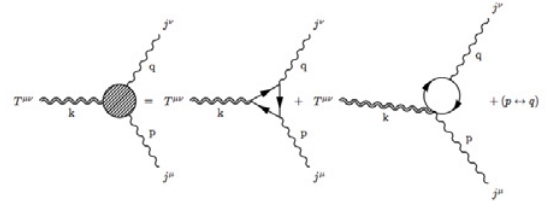
Figure 1. Diagrammatic expansions of the TVV